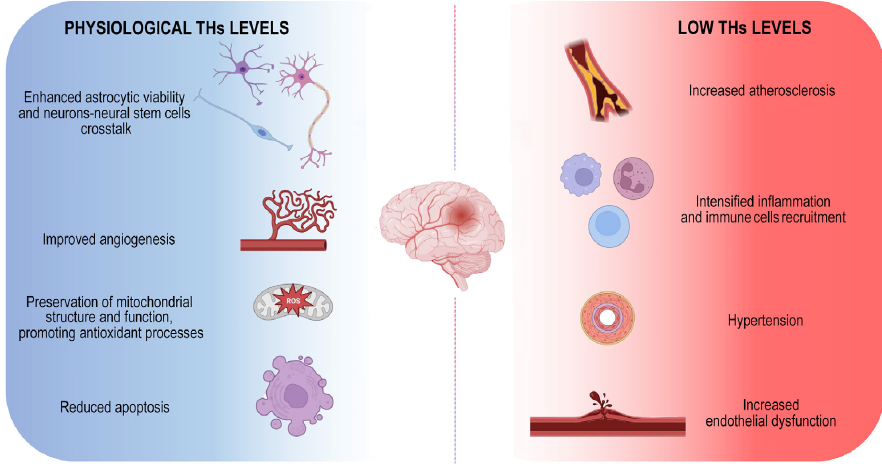
Figure 1. Physiological THs maintenance is essential to counteract ischemic stroke onset. Schematic illustration of positive THs-dependent effects on brain. The image represents the harmful conse- quences of low THs levels indicating the main mechanisms by which they influence the onset of the disease.